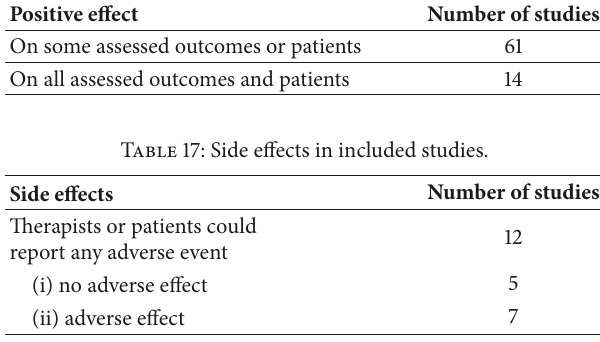
Table 16: Positive effect in included studies.